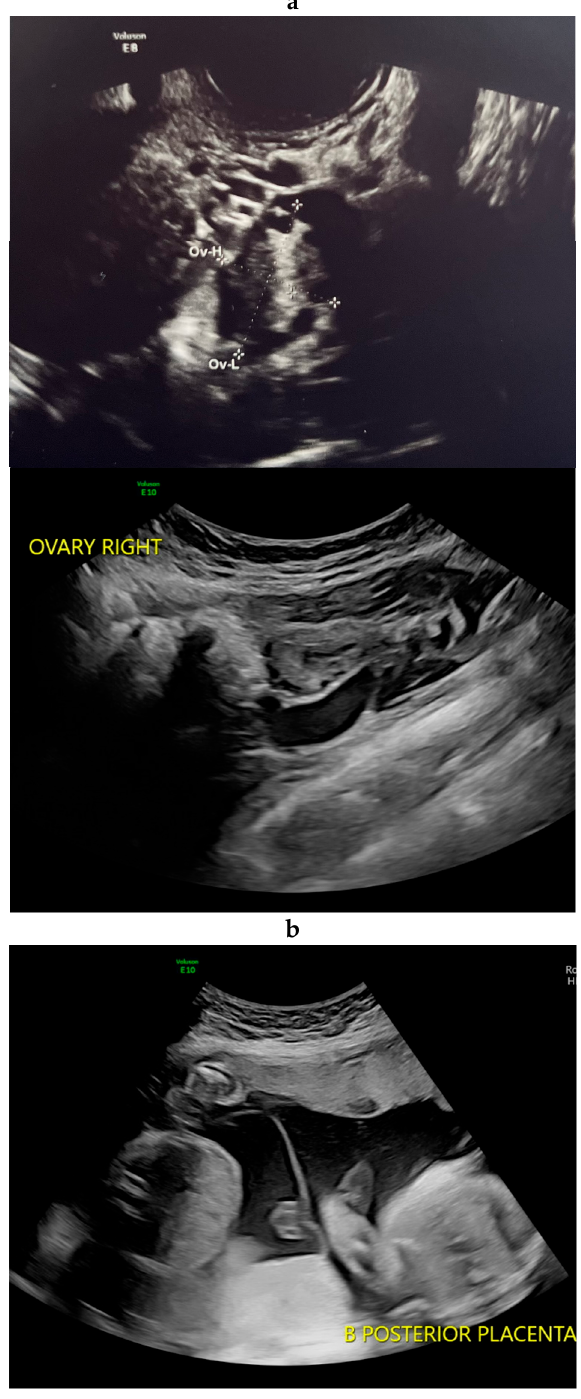
Figure 2. Sonographic evidence of dichorionic, diamniotic pregnancy and no definitive corpus luteum. ( a ). Early pregnancy ultrasound at 6 weeks 5 days gestation. ( b ). Anatomic survey ultrasound at 24 weeks 6 days gestation.